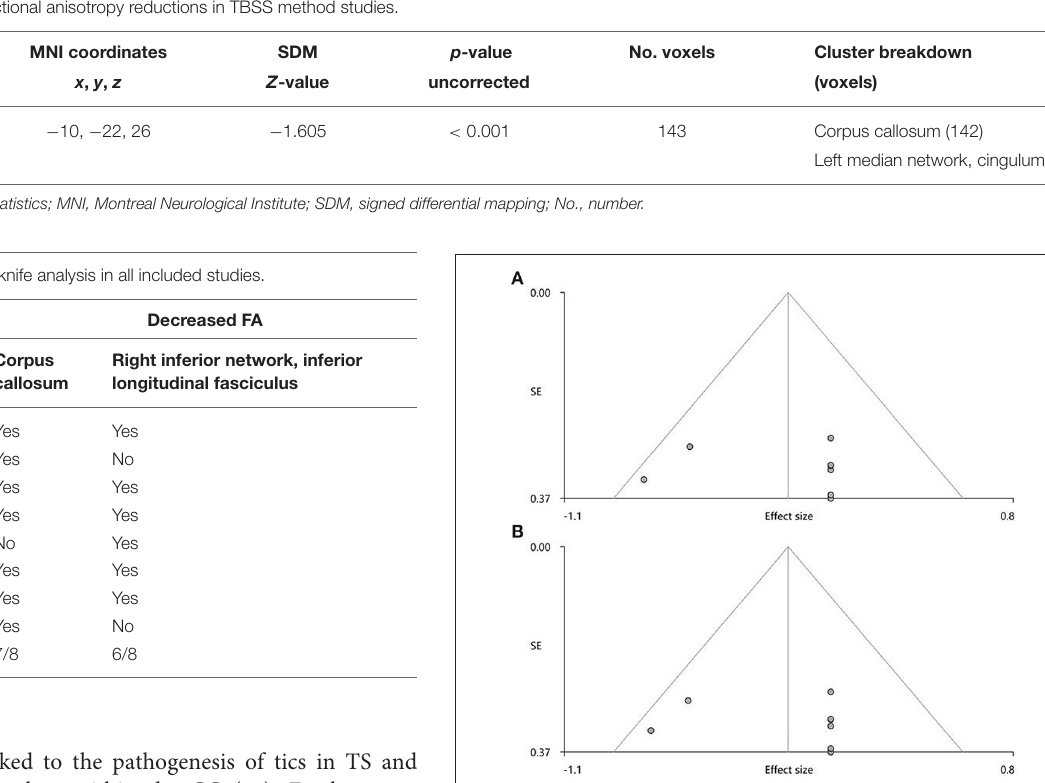
FIGURE 3 | Results of funnel plot analysis to test for publication bias. For the pooled meta-analysis, the Egger’s test and funnel plots revealed no significant publication bias (A) in the corpus callosum ( Z = 0.75, t = 0.22, df = 6, p = 0.832) and (B) in the right inferior network, inferior longitudinal fasciculus ( Z = 1.14, t = 0.34, df = 6, p =